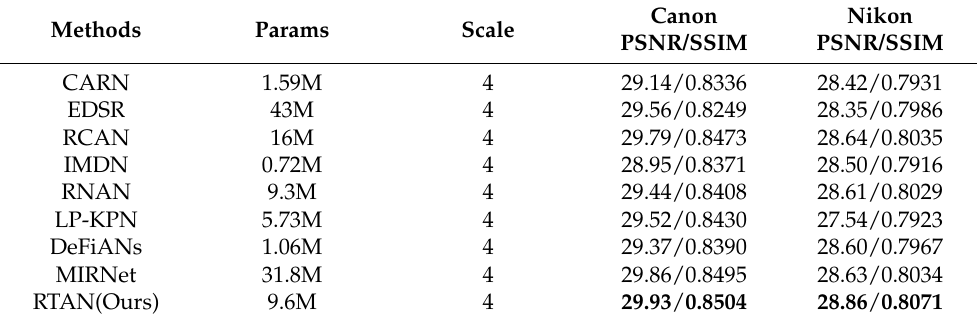
Table 5. The quantitative results (i.e., average PSNR/SSIM) with real-world degradation model on datasets Canon and Nikon. The best results are highlighted.